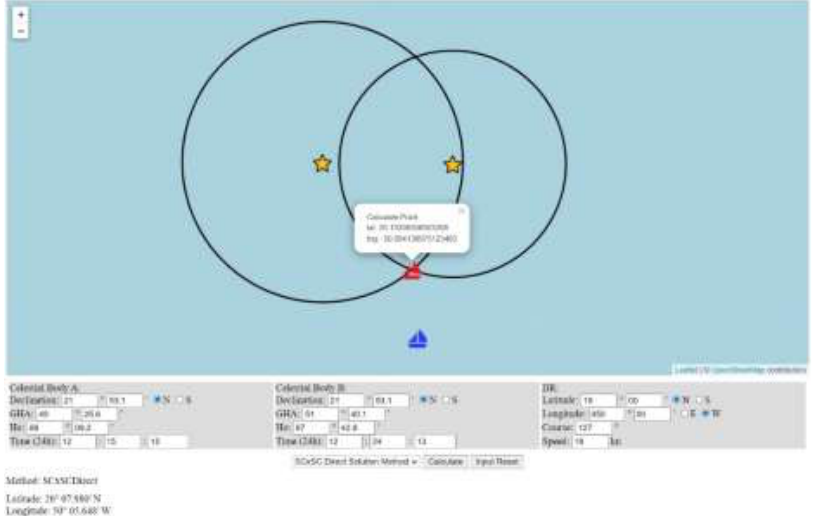
Figure 10. The GUI of the closed analytical solution method calculation program (for example 2).